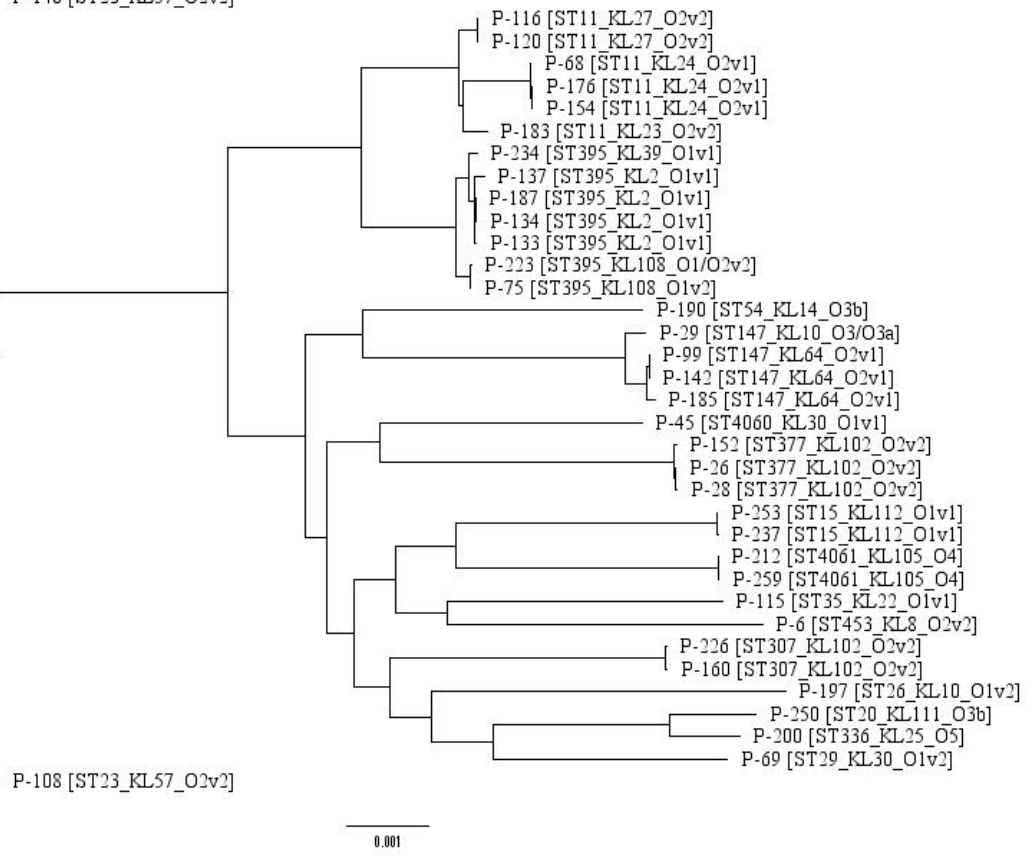
Figure 1. Maximum likelihood phylogenetic tree of the 36 K. pneumoniae isolates studied.